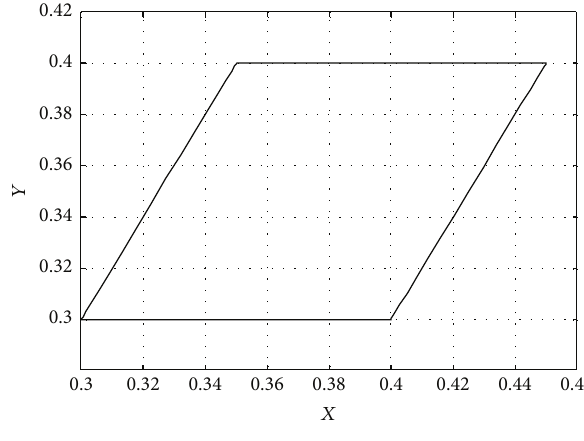
Figure 4: 𝑋 - 𝑌 desired workspace